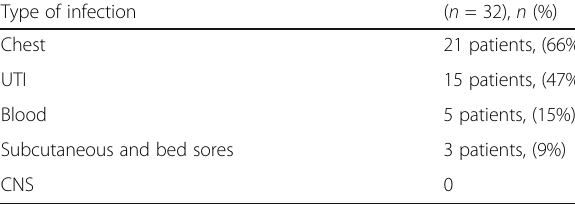
Table 3 Different types of infections in study